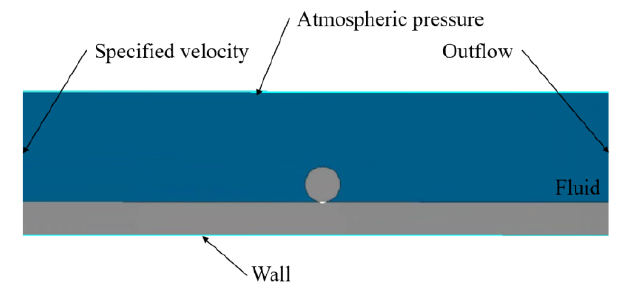
Figure 1. Model profile and boundary conditions.